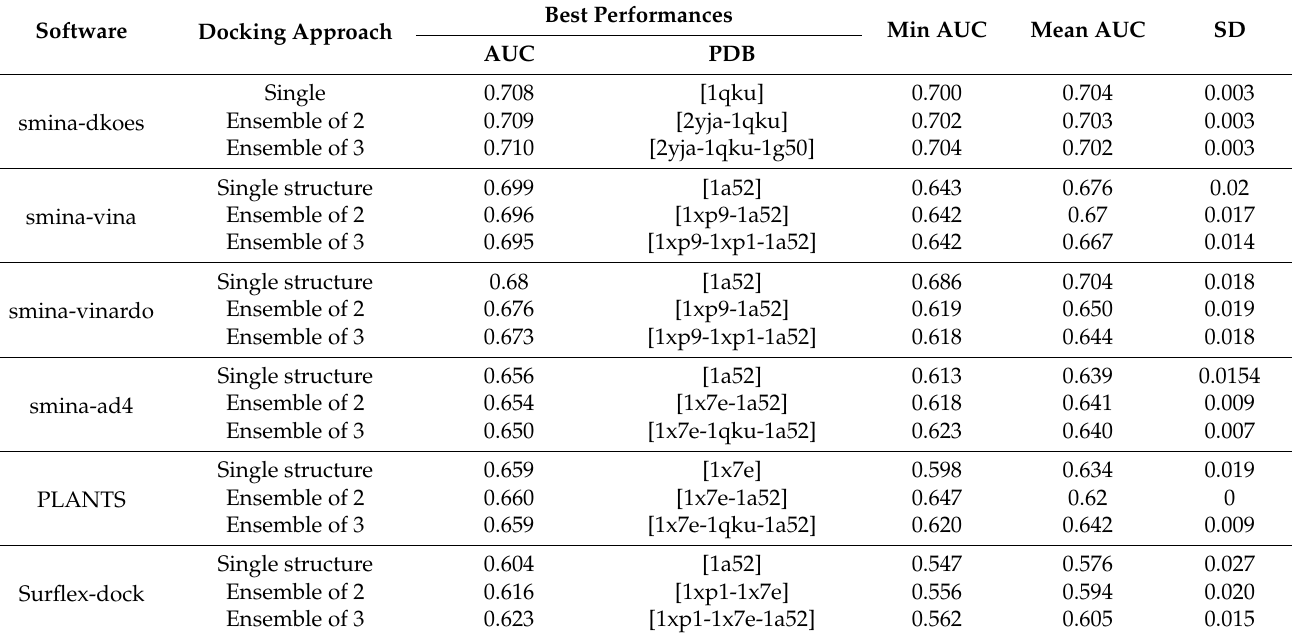
Table 1. Docking performances (Max area under the ROC curve (AUC), min, mean, and standard deviation (SD)) calculated for the different scoring functions and for the different docking approaches.